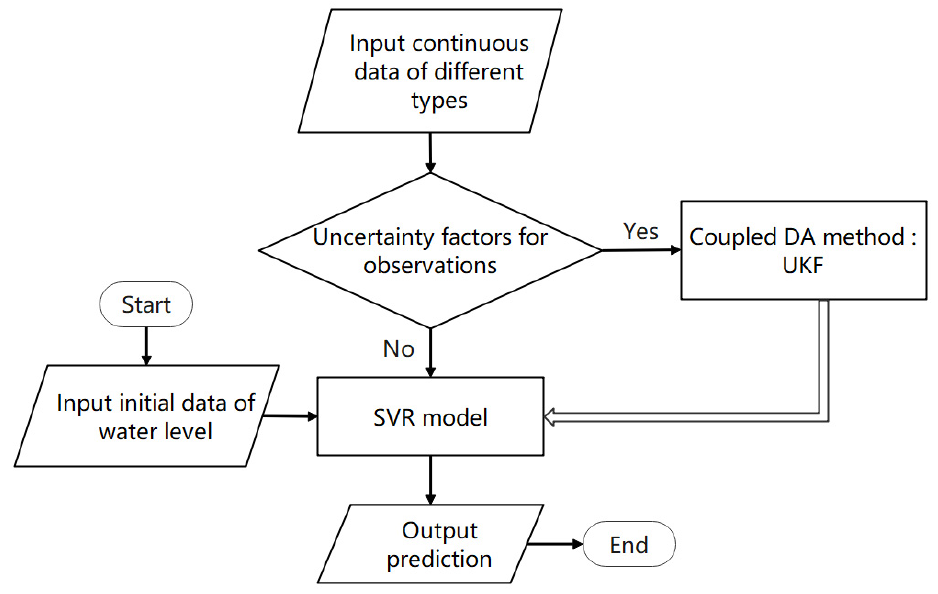
Figure 3. Study flow chart.